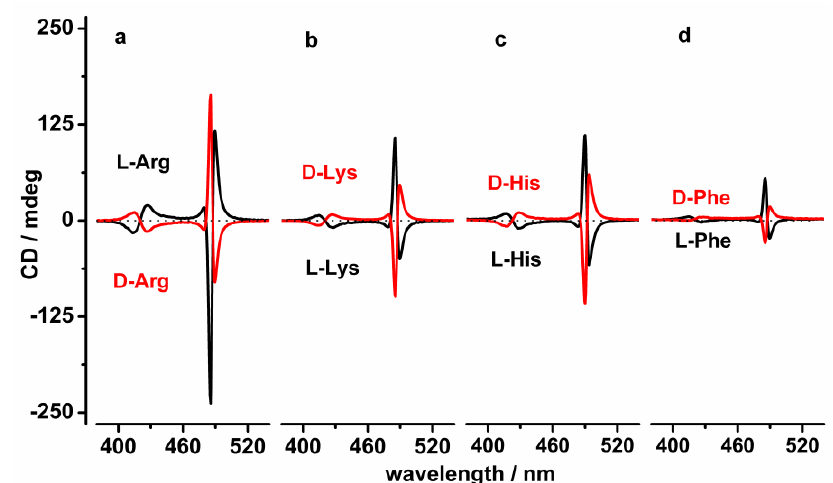
Figure 3. The CD spectra of J-aggregates obtained with the procedure “ acid last ” template on: ( a ) 1 mM Arg; ( b ) 1 mM Lys; ( c ) 1 mM His; and, ( d ) 1 mM Phe. Black curves represent L- amino acids and red curves represent D- amino acids.